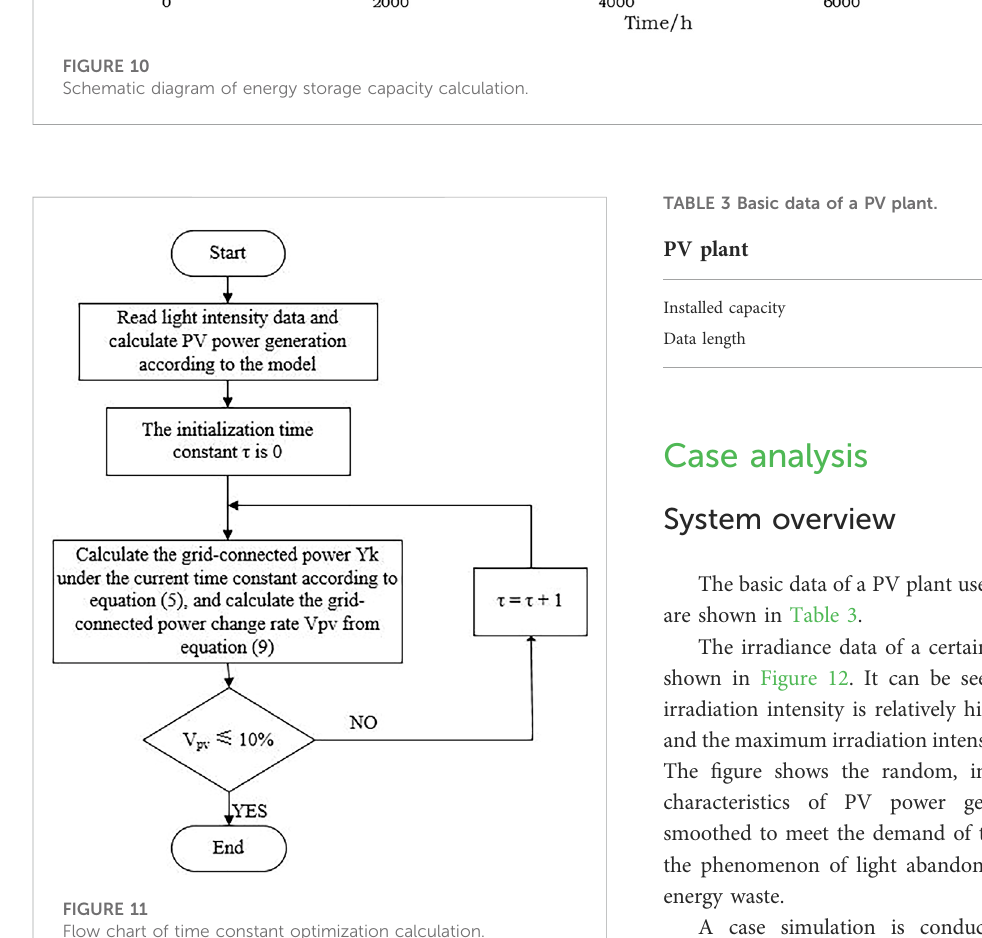
FIGURE 11 Flow chart of time constant optimization calculation.